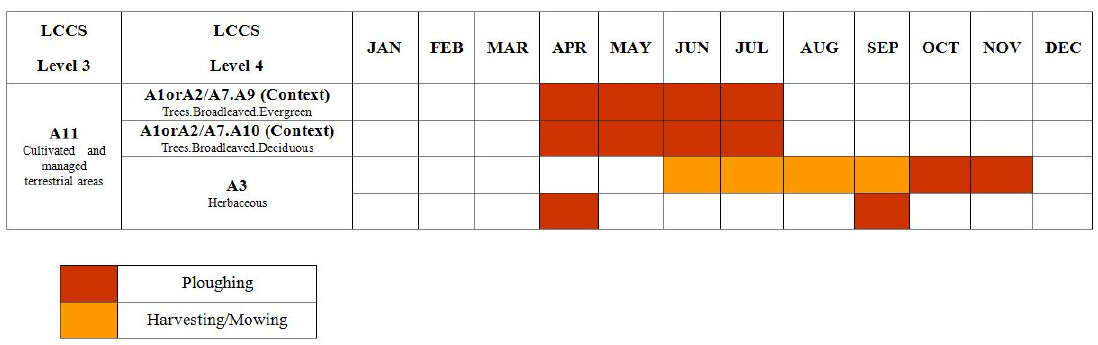
Figure 2. Phenology of vegetated classes in Murgia Alta.